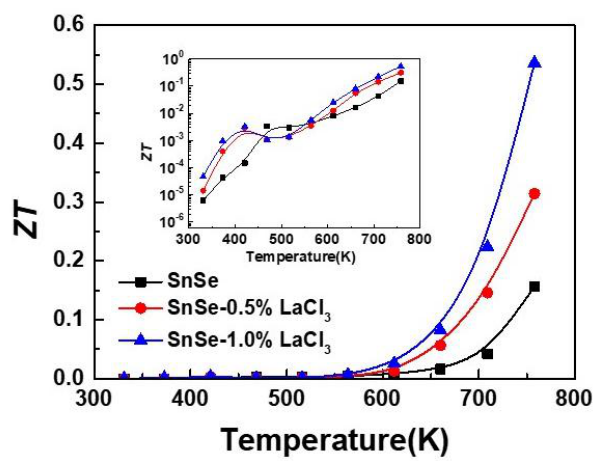
7 of 9 Figure 4. Thermal transport properties as a function of temperature for all the samples SnSe- x wt% LaCl 3 ( x = 0.0, 0.5, and 1.0). ( a ) Thermal diffusivity; ( b ) thermal conductivity. The ZT value as shown in Figure 5 was calculated by combining the electrical transport property and thermal conductivity. This shows that the ZT values for all the samples increase with increasing temperature. Because of the lower electrical transport property and higher thermal conductivity, the maximum ZT value for the undoped sample is only 0.15. For all the doped samples, the values are similar to those of the undoped ones in the temperature range of 300 to 600 K. However, attributed to the enhanced electrical conductivity and reduced lattice thermal conductivity with rising the